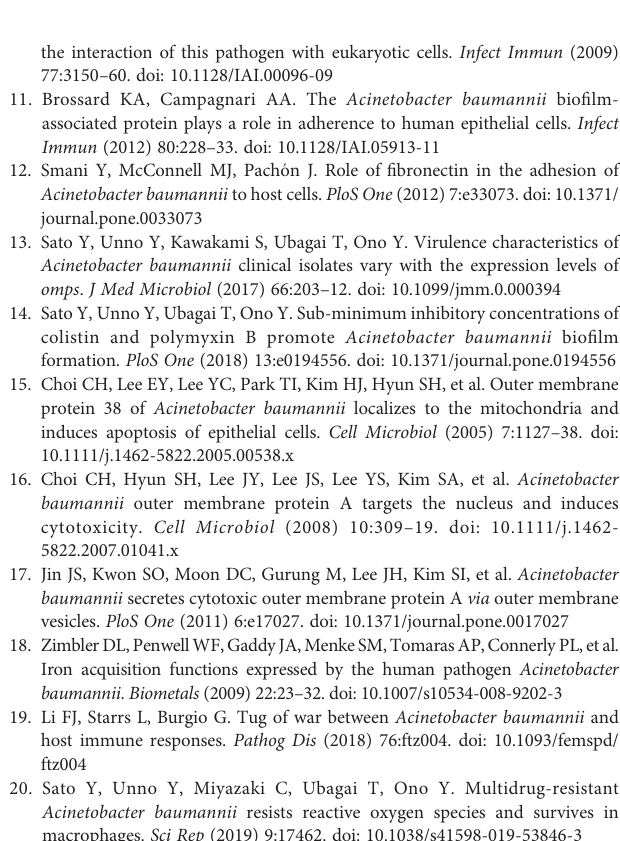
SUPPLEMENTARY FIGURE 6 | Phenotypic analysis of innate immune cells in the spleen of Acinetobacter baumannii -infected and uninfected klotho knockout (KO) mice. Innate immune cells in the spleen of A. baumannii -infected and uninfected klotho KO mice were analyzed for their expression of the following cell- surface markers: CD11b, CD11c, Ly-6C, Ly-6G, and F4/80. A representative result of 4-color fl ow cytometric analysis of the innate immune cell population in SUPPLEMENTARY FIGURE 7 | Number of innate immune cells in the spleen of klotho wildtype (WT) and knockout (KO) mice before and after infection with Acinetobacter baumannii . Summarized results show the number of (A) neutrophils, (B) eosinophils, (C) monocytes, (D) macrophages, and (E) dendriticcells(DC)inthe spleen of A. baumannii -infected klotho WT and KO mice. Line graphs were compiled from 4 independent experiments ( n = 16 for WT and n = 16 for KO mice), and represent the mean ± SEM.Asterisks indicate statistically signi fi cant differences as follows: ** P < 0.01, * P < 0.05, klotho WT mice before infection vs. klotho